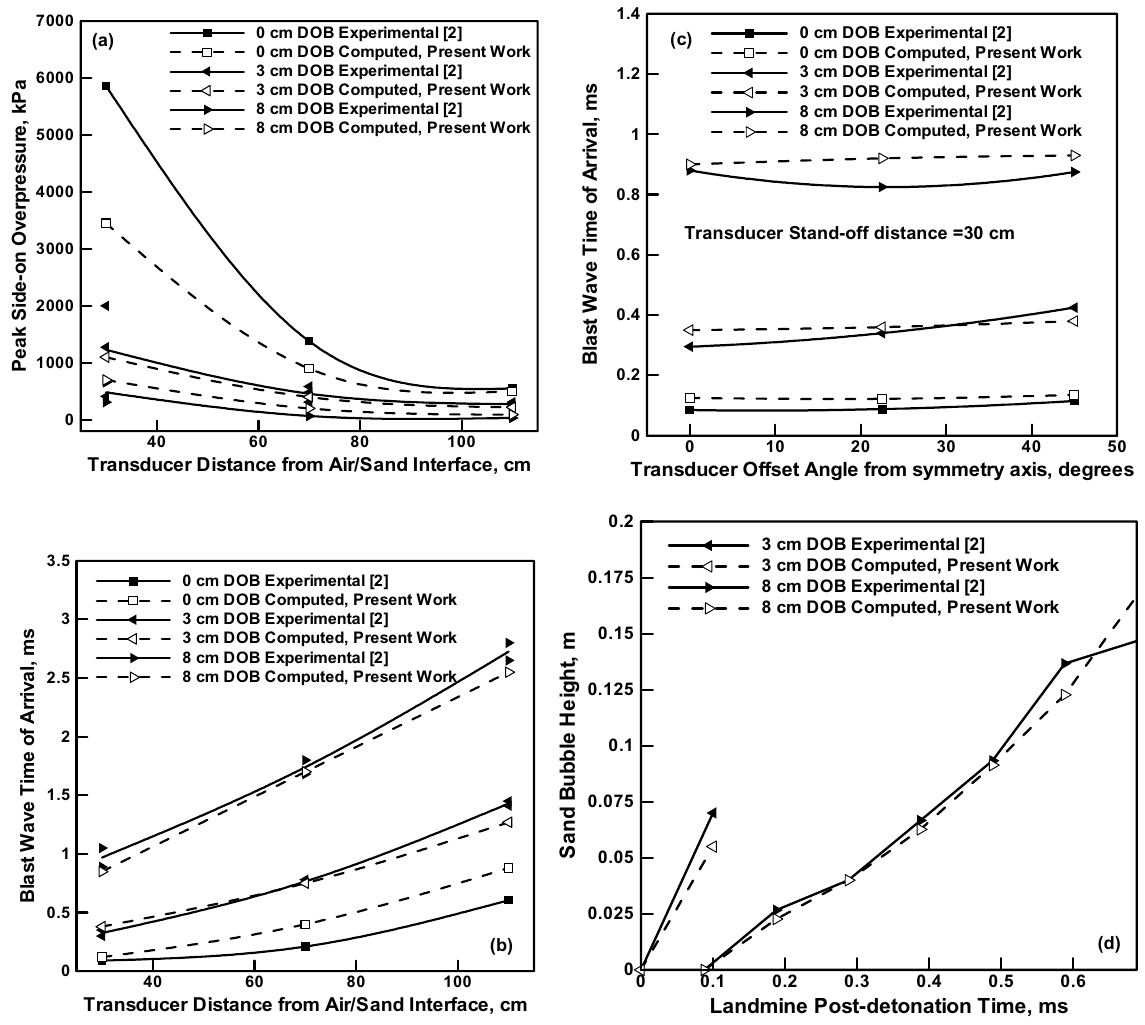
Fig. 8. A comparison of the experimental [2] and computed (present work) results pertaining to various phenomena associated with landmine detonation in dry sand: (a) Side-on overpressure vs. transducer distance from air/sand interface; (b) Blast wave arrival time vs. transducer distance from air/sand interface; (c) Blast wave arrival time vs. transducer offset angle from the symmetry axis and (d) Sand bubble height vs. landmine post-detonation